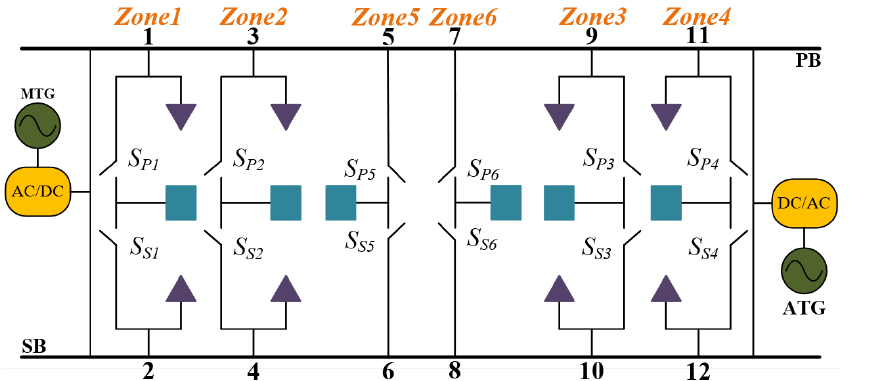
Figure 3. Real time simulator and system configuration.